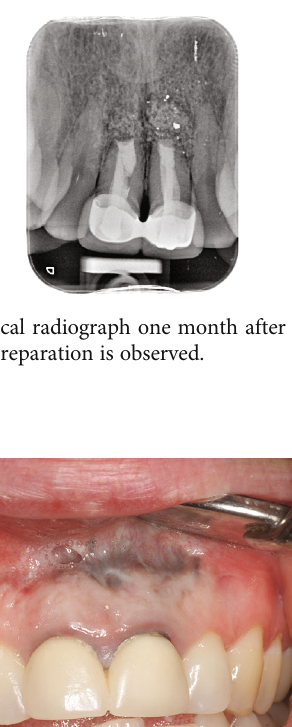
Figure 24: Periapical radiograph one year after surgery, showing complete bone regeneration of 1.1 and 2.1.